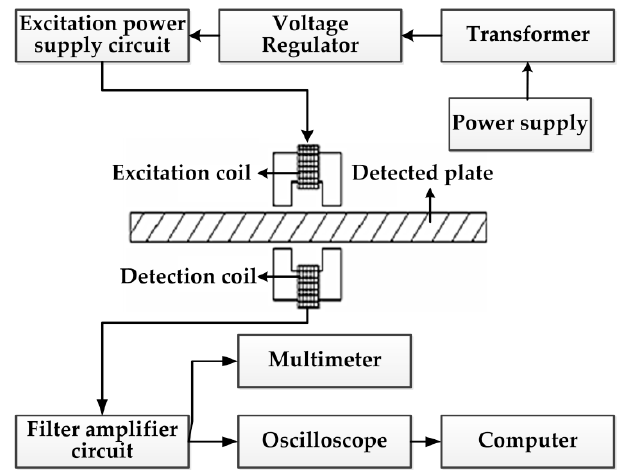
Figure 6. Principle diagram of the magnetic stress detection system.